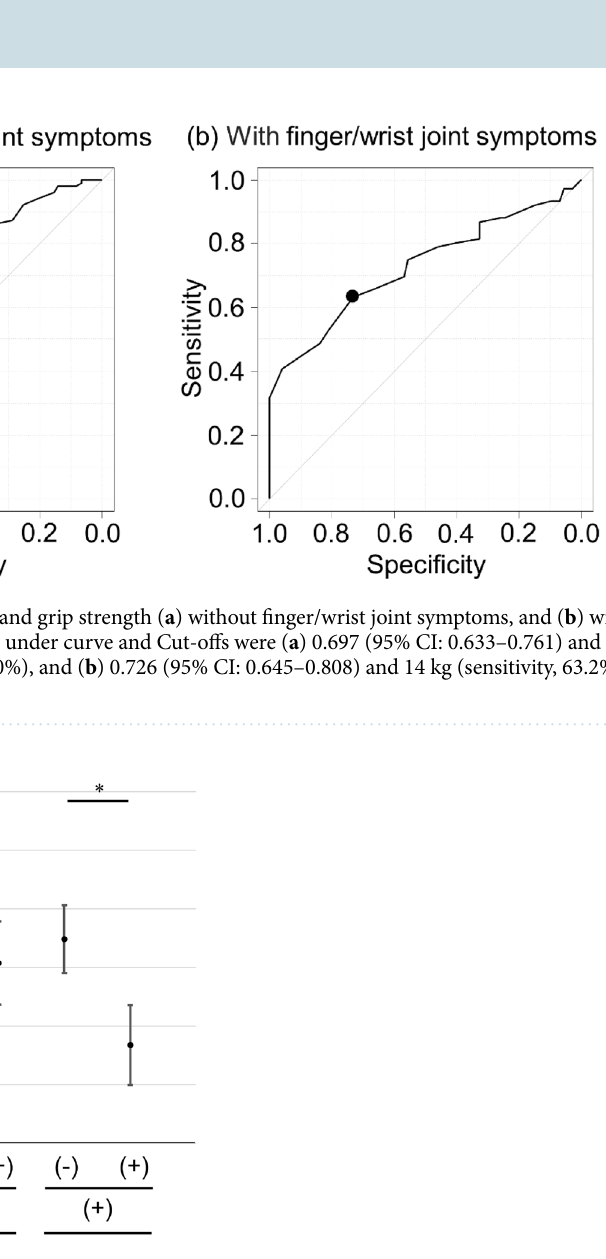
Figure 2. Estimated marginal means of grip strength with age, duration of disease, and BMI as covariates. In order from left to right, subjects with no frailty and no finger/wrist joint symptoms (n = 171, 40.3%), with frailty and no finger/wrist joint symptoms (n = 103, 24.3%), with no frailty and finger/wrist joint symptoms (n = 74, 17.5%), and with frailty and finger/wrist joint symptoms (n = 76,